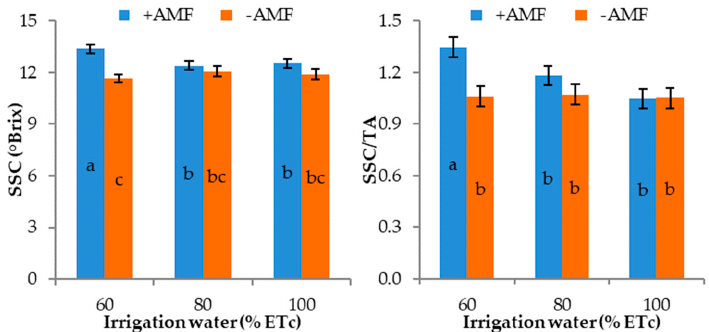
Figure 11. Effect of irrigation treatments and plant inoculation with arbuscular mycorrhizal fungi (AMF) on soluble solid content (SSC) and soluble solid content: titratable acidity ratio (SSC/TA) of melon fruit during two years of experiments (for each parameter, bars with different letters are significantly different at p < 0.05 according to the LSD test).